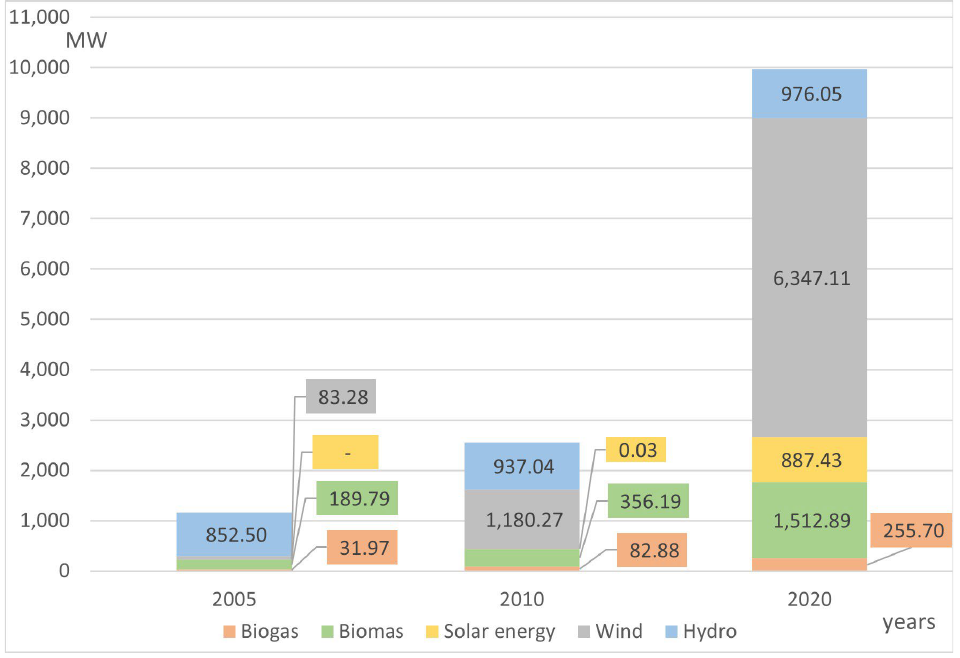
Figure 7. Installed capacity by type of RES in Poland in the years 2005–2020 in (MW). Source: Renewable Energy Resources. Statistical Yearbook, SP.